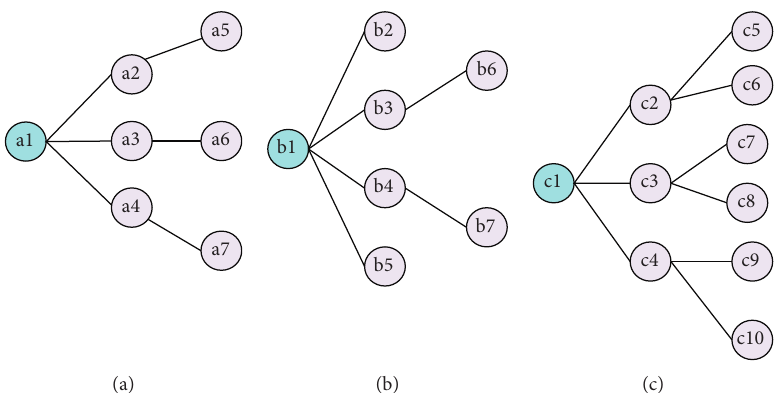
Figure 3: The diagram of local hybrid influence of the degree and H -index. (a) D � 3 and H � 2 for a1; (b) D � 4 and H � 2 for b1; and (c) D � 3 and H � 3 for c1.